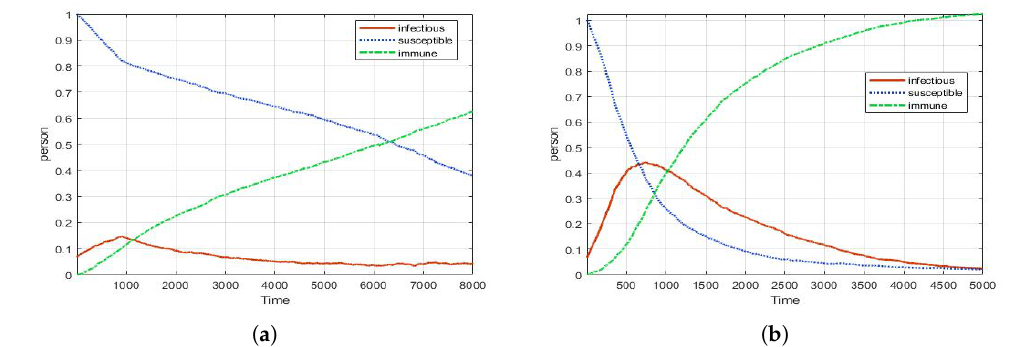
Figure 13. The effect of control measure (from Super-spreader). ( a ) No Super-spreaders (peak: 0.1); ( b ) Super-spreaders present (peak: 0.44).